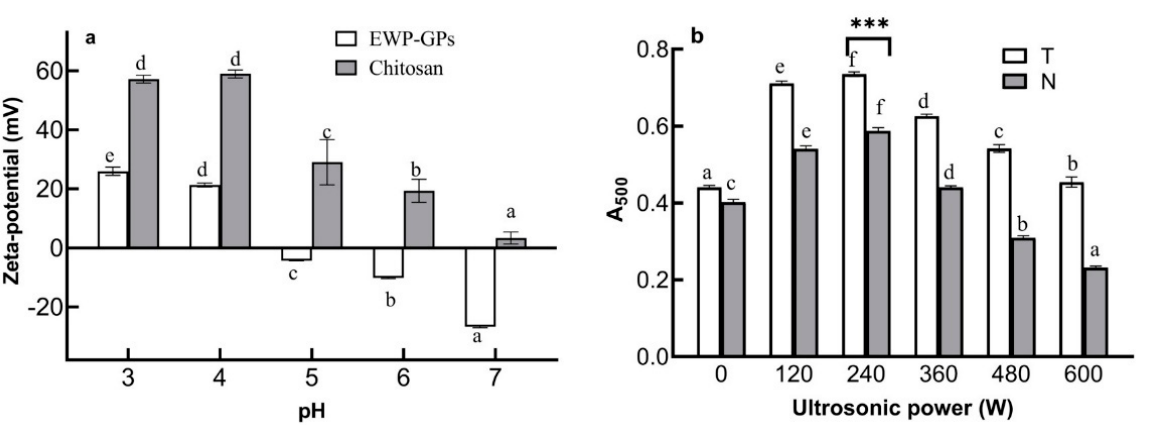
Figure 3. The effect of pH on the potential of EWP-GPs and chitosan ( a ). The emulsification of EWP-GPs ( b ). (Values with different letters are significant at p < 0.05, and *** represents p < 0.001).